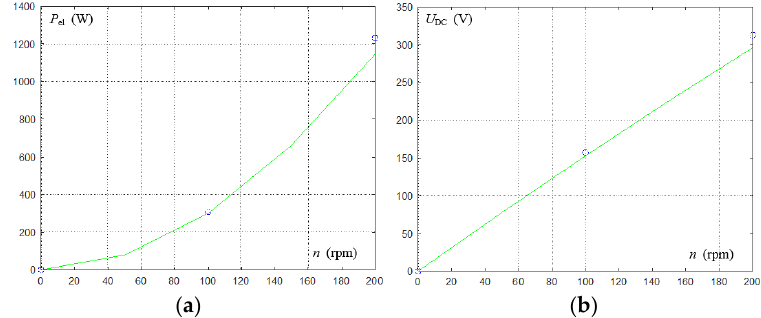
Figure 31. ( a ) Generator G4-power as a function of rotational speed for different resistive loads; ( b ) generator G4-voltage as a function of current for selected rotational speed values; points-measurement results, solid line-analytical calculations.